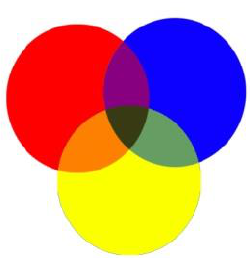
Figure 1. Crossing and union of sets of Design (D), Training (T), Knowledge assessment